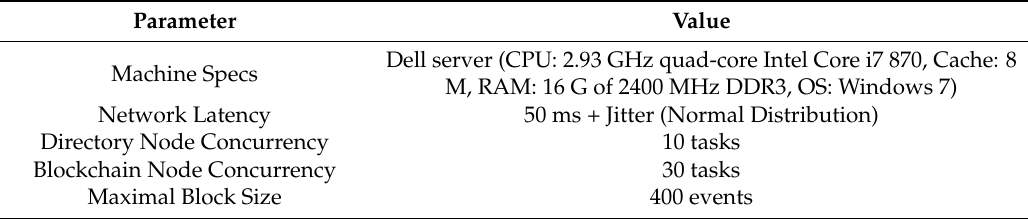
Table 3. Parameters of the experiment